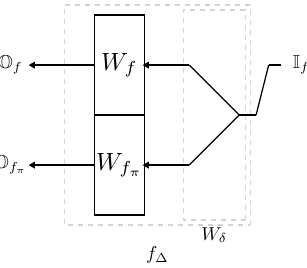
, multiplied by W π δ